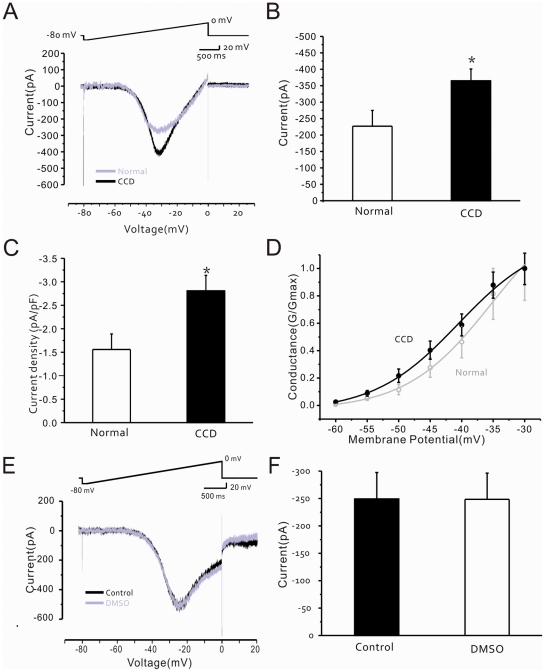
Enhanced INaP in A-type neurons of the compressed DRG.(A) Traces of INaP in A-type neurons from control (normal; grey line) and compressed (CCD, solid line) DRGs (bottom) as induced by increasing applied voltage (top). (B) Bar graph showing that the average peak INaP is significantly greater in neurons recorded from compressed DRGs (CCD; n = 31) compared to the average peak value from control group recordings (normal; n = 26; *P<0.05). (C) Bar graph showing that average peak INaP current density is significantly greater in compressed DRG neurons (n = 31) compared to the average peak value from control group recordings (n = 26; *P<0.05). (D) Steady state activation curves for INaP conductance with respect to voltage in control and compressed DRG neurons as fit with a Boltzmann distribution equation. The differences are not statistically significant. (E) Traces of INaP in a compressed DRG neuron in the absence (control, solid line) and presence (DMSO, grey line) of 0.1% DMSO (bottom) as induced by increasing applied voltage (top). (F) Bar graph showing that average peak INaP in compressed DRG neurons (n = 7) in the presence of 0.1% DMSO is not significantly different from the average peak INaP in the absence of DMSO (control, filled; n = 7; P>0.05).